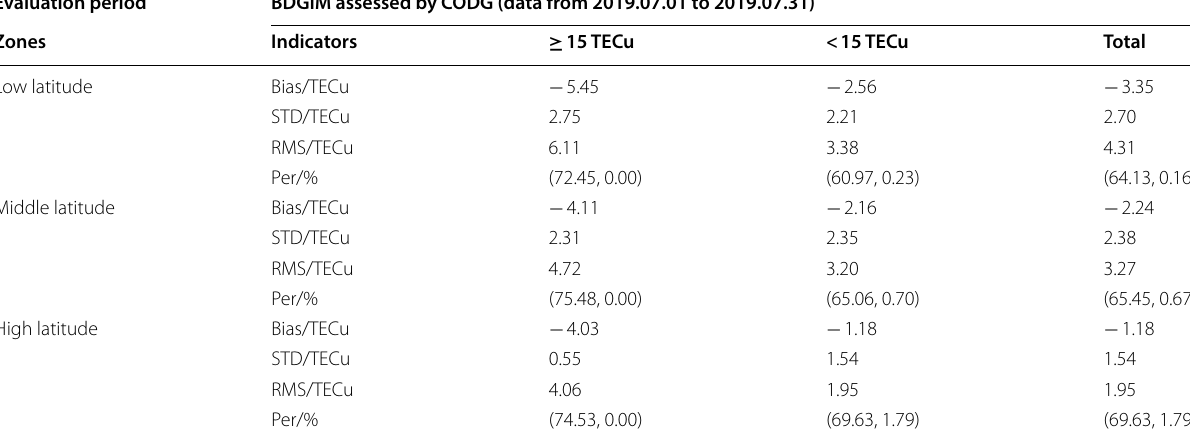
Table 2 Accuracy evaluation of BeiDou global ionospheric model Evaluation